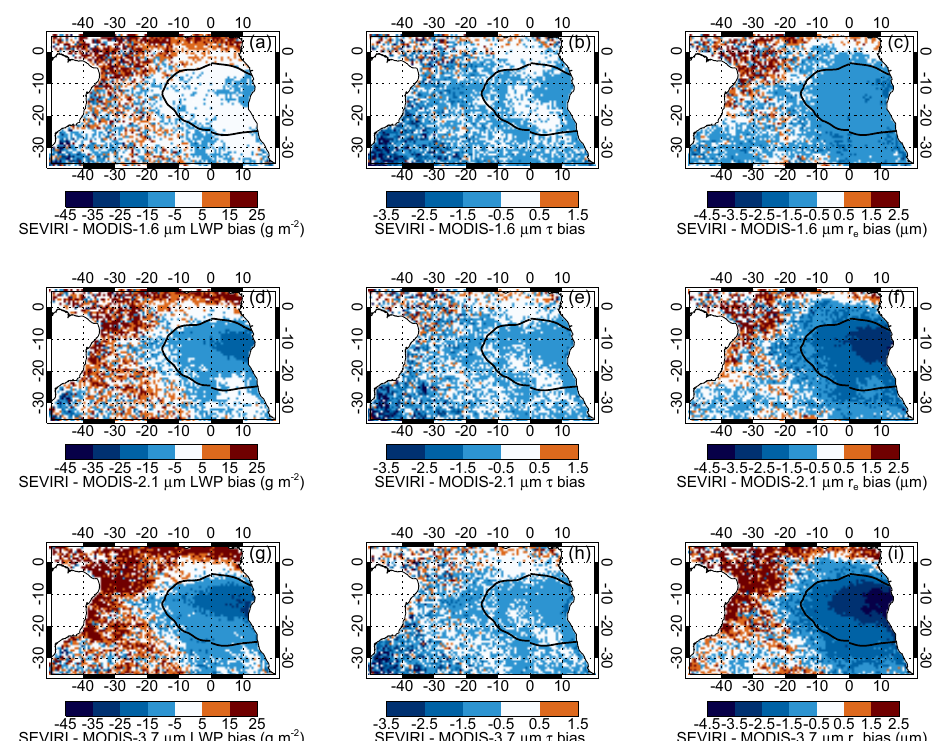
Figure 3. Spatial distribution of SEVIRI liquid water path biases (a, d, g) , cloud optical thickness biases (b, e, h) , and droplet effective radius biases (c, f, i) , compared to MODIS 1.6, 2.1, and 3.7µm channel retrievals, respectively, averaged for JAS 2011 and JAS 2012 for overcast (LCF ≥ 95% and τ > 3) rain- and ice-free